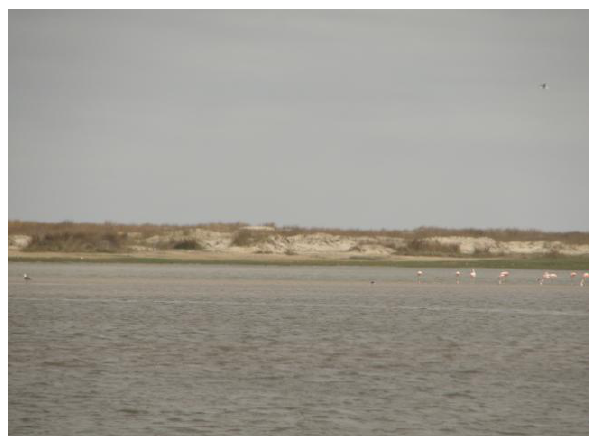
Figure 1. Study area situation map (A), the Lagoa do Peixe National Park border (red line) (B) and the Lagoa do Peixe channel (C).